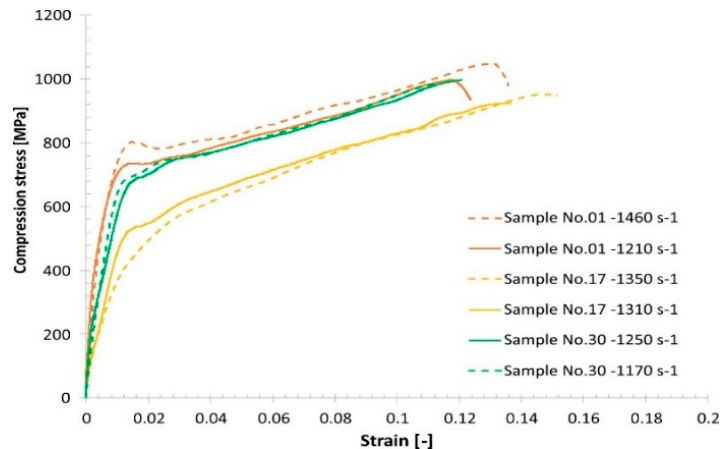
Figure 15. Results of the Split–Hopkinson pressure bar (SHPB) compression tests under dynamic loading conditions.